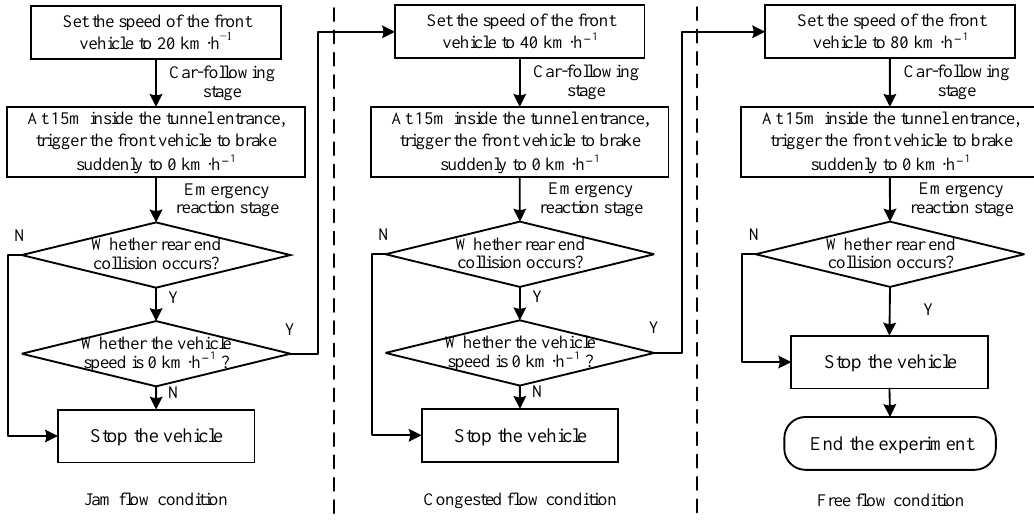
Figure 4. The experimental process flow diagram .